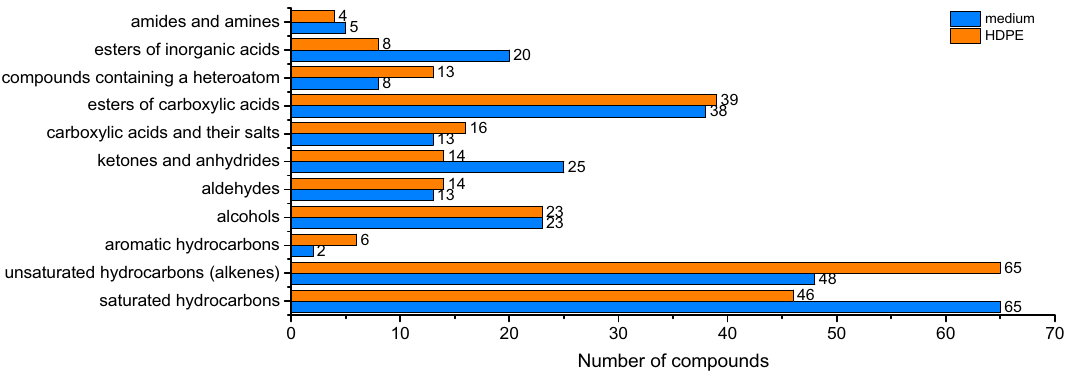
Fig. 3 Type of compounds detected in the medium and organic matter around the surface of HDPE after degradation with all tested bacte- rial species